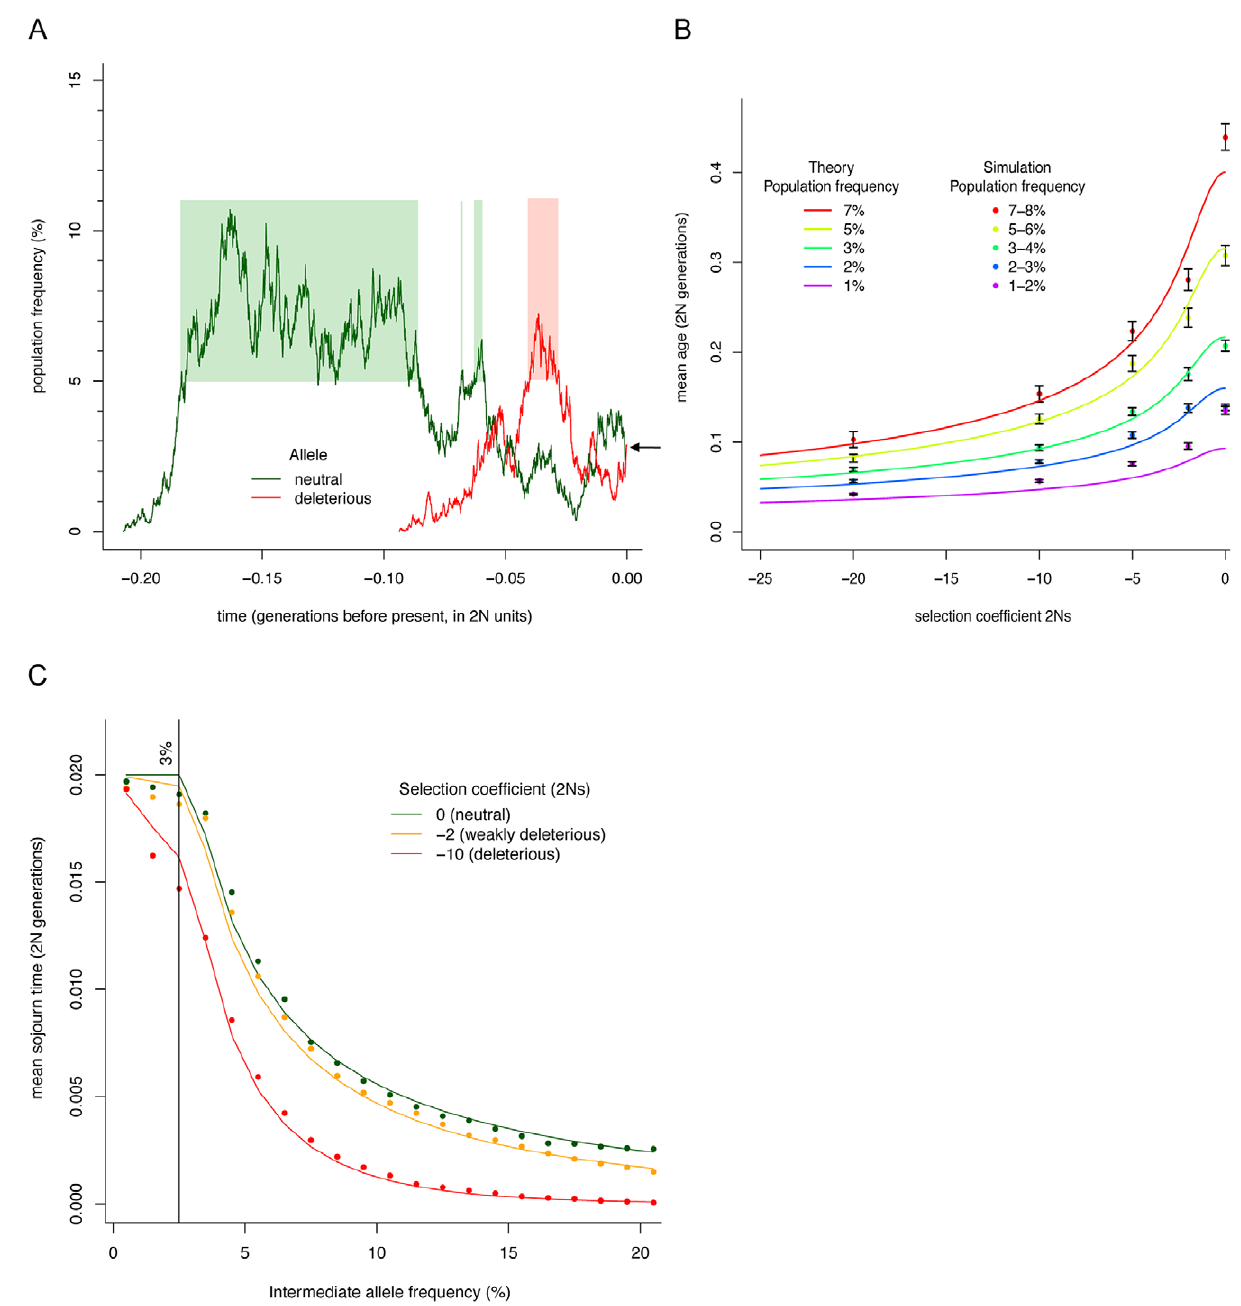
Figure 1. Simulation and theoretical results for allelic age and sojourn times. a. Example trajectories for a neutral and deleterious allele with current population frequencies 3% (indicated by the arrow). The shaded areas indicate sojourn times at frequencies above 5%. b. Mean ages for neutral and deleterious alleles at a given population frequency (lines show theoretical predictions, dots show simulation results with standard error bars). Simulation results are averages of alleles in a frequency range, while theoretical prediction are for alleles at a fixed frequency. The graph shows that deleterious alleles at a given frequency are younger than neutral alleles, and that the effect is greater for more strongly selected alleles. c. Mean sojourn times for neutral and deleterious alleles. Vertical line denotes the current population frequency of the variant (3%). Mean sojourn times have been computed in bins of 1%. Line connects theoretical predictions for each frequency bin. Dots show simulation results. The graph illustrates that deleterious alleles spend much less time than neutral alleles at higher population frequencies in the past even if they have the same current frequency.